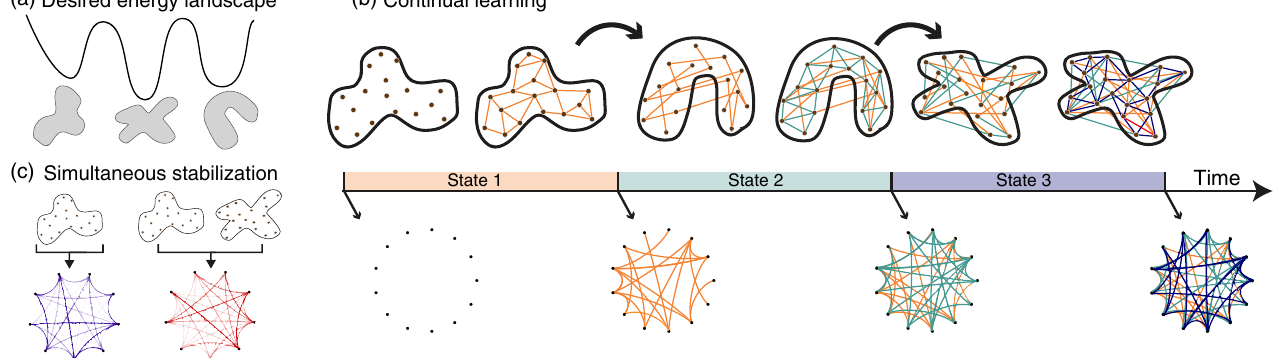
FIG. 1. Continually learned multistability. (a) We seek to create an elastic network with specific stable configurations (energy minima). (b) In continual learning, the network grows incrementally; new bonds created in one epoch (e.g., purple) can only depend on the configuration (e.g., state 3) during that epoch and have no information about states in the past and the future. For continual learning of new states without forgetting older states, network changes due to learning state 3 should not interfere with the stability of state 1 and 2 or vice versa. (c) In contrast, in the usual approach, all desired states are specified beforehand and then network parameters (e.g., connectivity, spring constants) are optimized to simultaneously stabilize these states. Unlike with continual learning, adding more states requires redesigning the network from